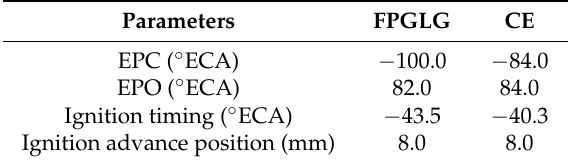
Table 5. Simulation parameters in the CFD combustion model of the FPGLG and CE.